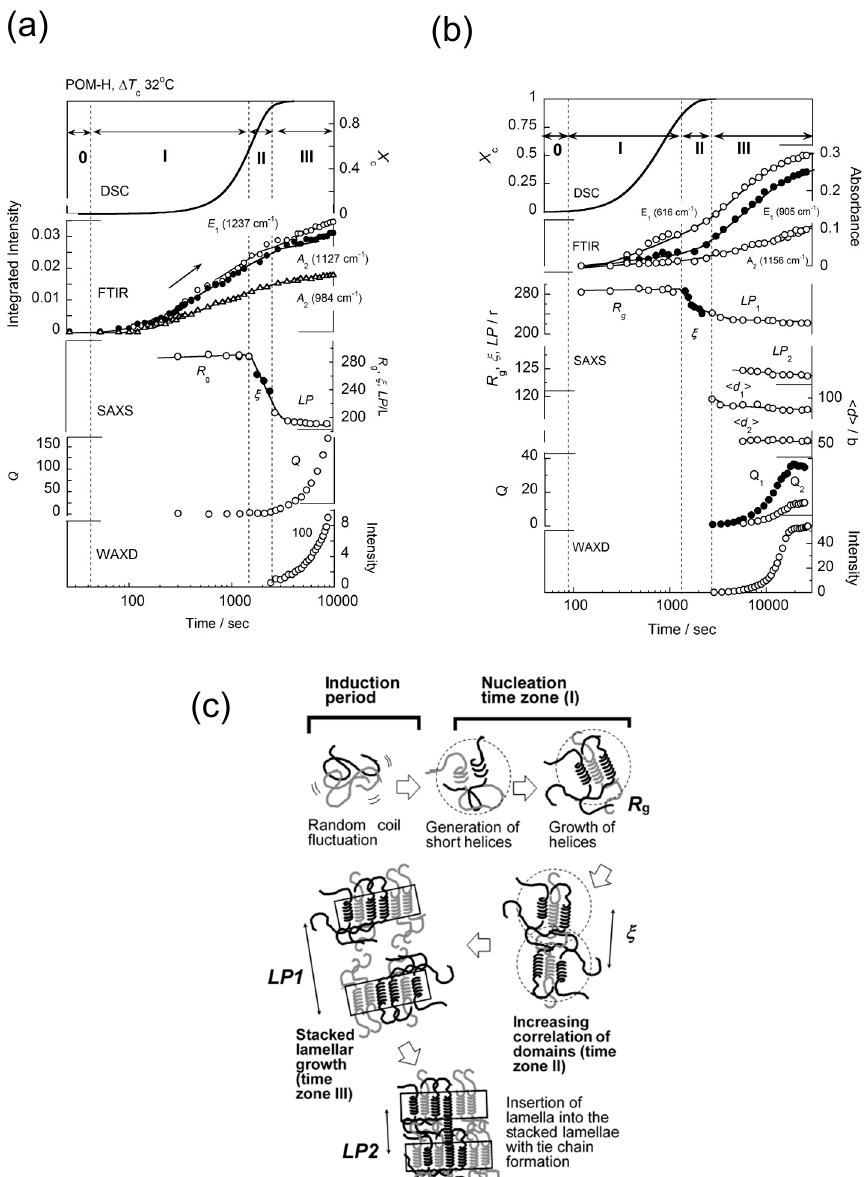
Figure 6. ( a , b ) The time dependence of the structural data collected in the isothermal crystallization process of the POM-H and POM-D samples, respectively. ( c ) The illustration of the structural evolution, where the insertion of daughter lamellae is also included [32].